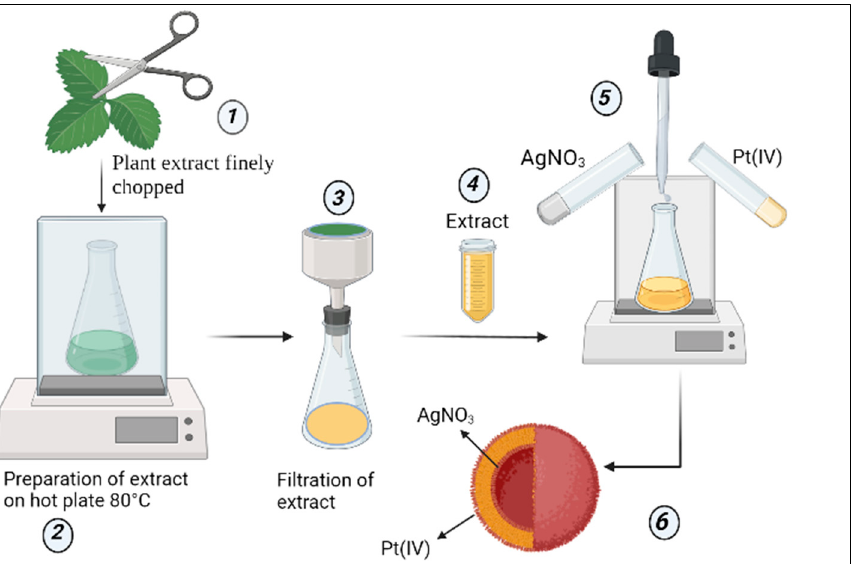
Figure 1. Schematic representation of synthesis of AgPtNPs from O. basilicum . (1) Fresh leaves of O. basilicum were chopped finely (2) Then, the finely chopped leaves were used for the preparation of the exact on a hot plate at 80 °C (3) The prepared extract was then filtered through a Whatman filter paper No.1 (4) This extract was used for the preparation of the bimetallic NPs (5) At 80 °C, and under continuous shaking conditions in the presence of two noble metals, namely Silver nitrate and Potassium tetrachloroplatinate (II), synthesis of the NPs was carried out (6). The hypothesis was that the NPs formed would possess an inner core of silver and outer cover of platinum.